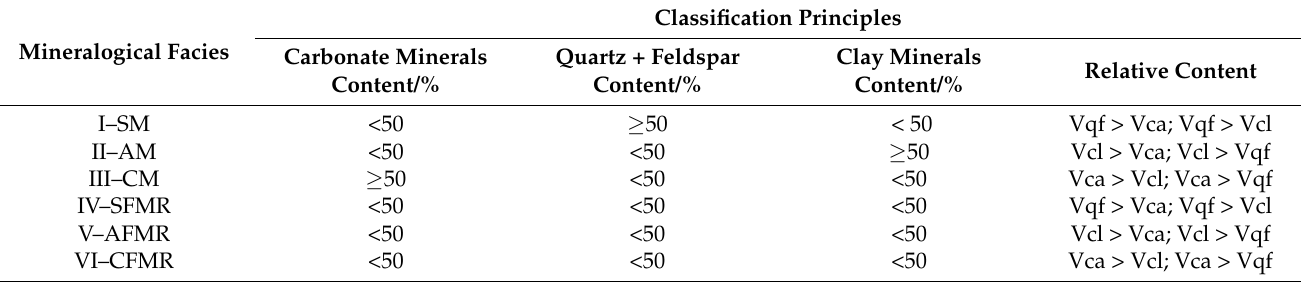
Table 1. Mineralogical lithofacies classification principle of the FGSRs.